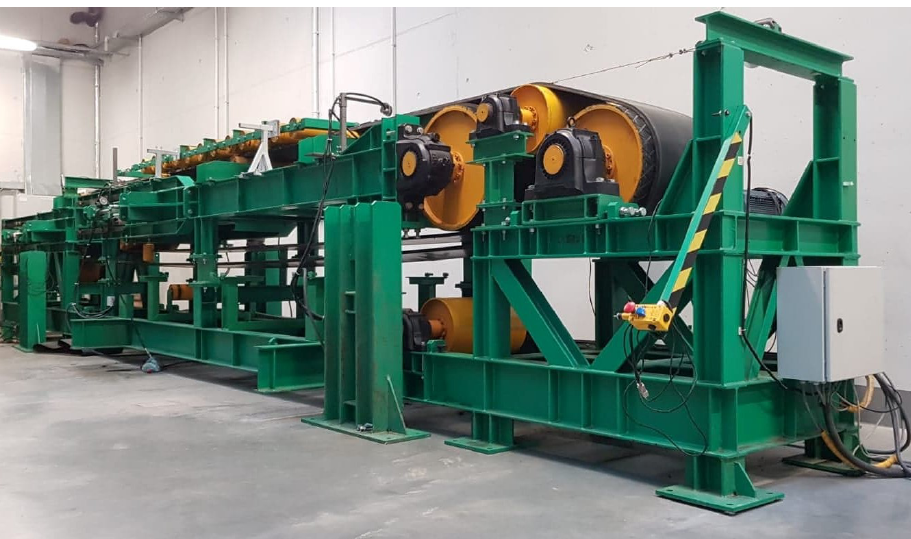
Figure 2. General view of the test